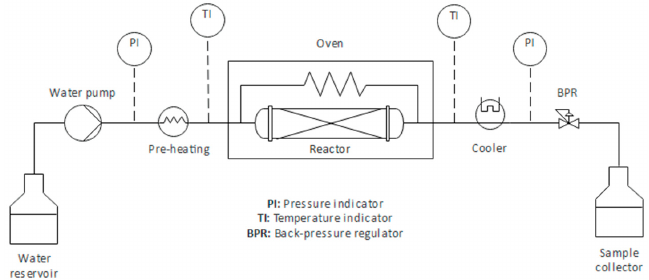
/ hydrolysis of granulated